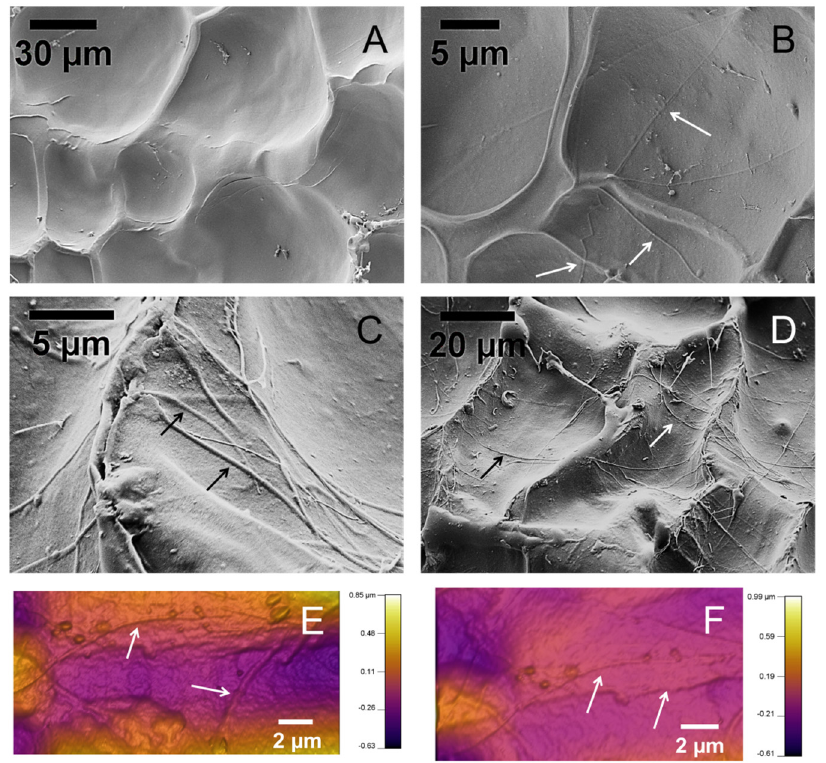
Figure 3. SEM and AFM images of the surface of the hydrogel samples. ( A ) A hydrogel sample with no collagen fibrils; ( B – D ) Composite hydrogel samples with collagen fibrils, ( B ) 1X, ( C , D ) 2X; ( E , F ) AFM topography images of collagen-alginate hydrogel samples. Arrows point to collagen